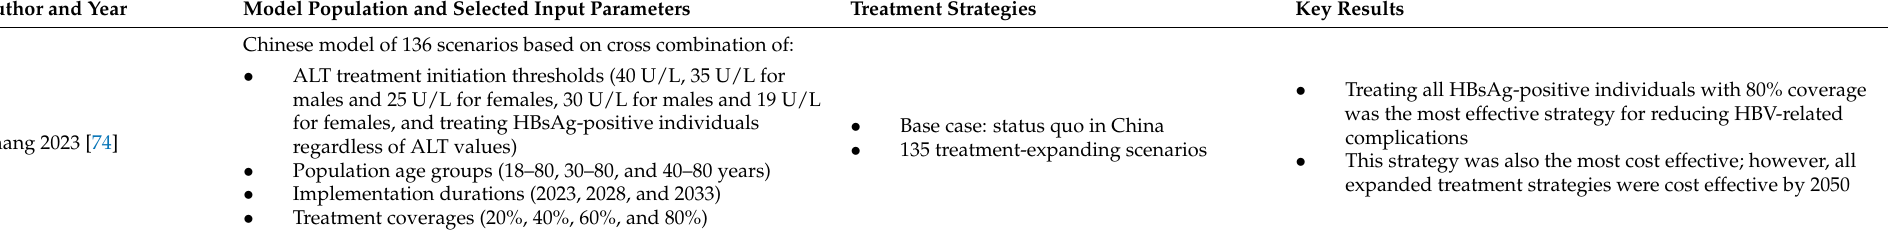
Table 3. Cost effectiveness and clinical impact of the expanded HBV treatment